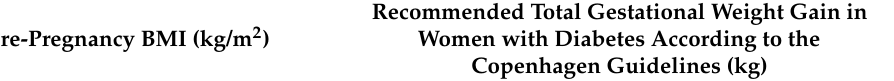
Table 2. Recommendations for pregnant women with diabetes: The Copenhagen guidelines on total gestational weight gain for women with diabetes, based on pre-pregnancy BMI [60] including a daily intake of a minimum of 175 g of carbohydrate, mainly from low-glycaemic-index carbohydrates sources, irrespective of pre-pregnancy BMI